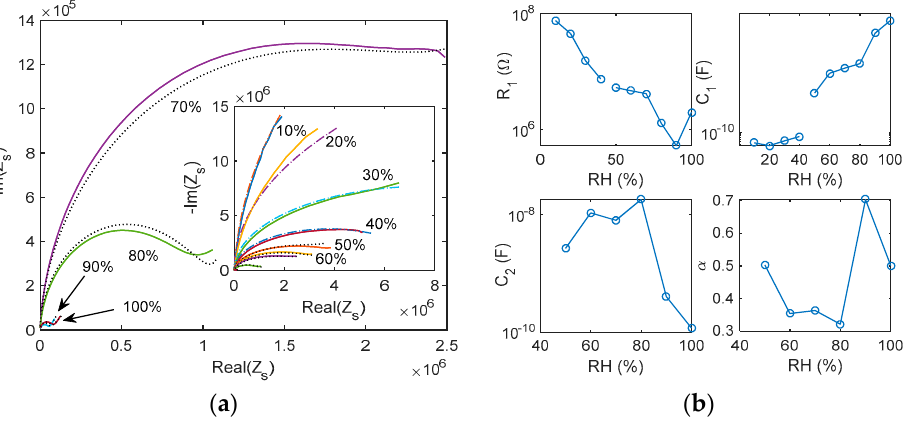
Figure 11. ( a ) Impedance Nyquist plots in the frequency range 50 Hz–80 kHz at different and constant RH levels for the pure TiO 2 sample; solid-colored lines: experimental data (as per legend); dotted lines: equivalent model fitting results. ( b ) Estimated parameters of the equivalent circuits: R 1 (upper left plot), C 1 (upper right plot), C 2 (lower left plot) and α (lower right